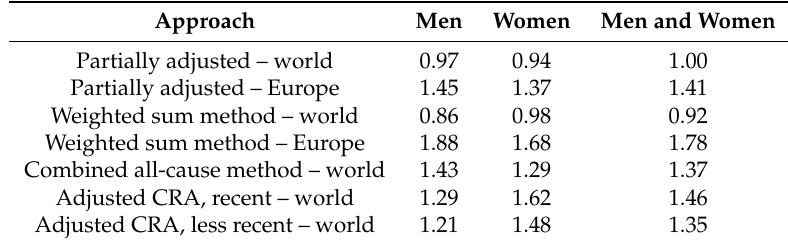
Table 3. Estimates of the percentage of deaths attributed to obesity by method and sex in The Netherlands in